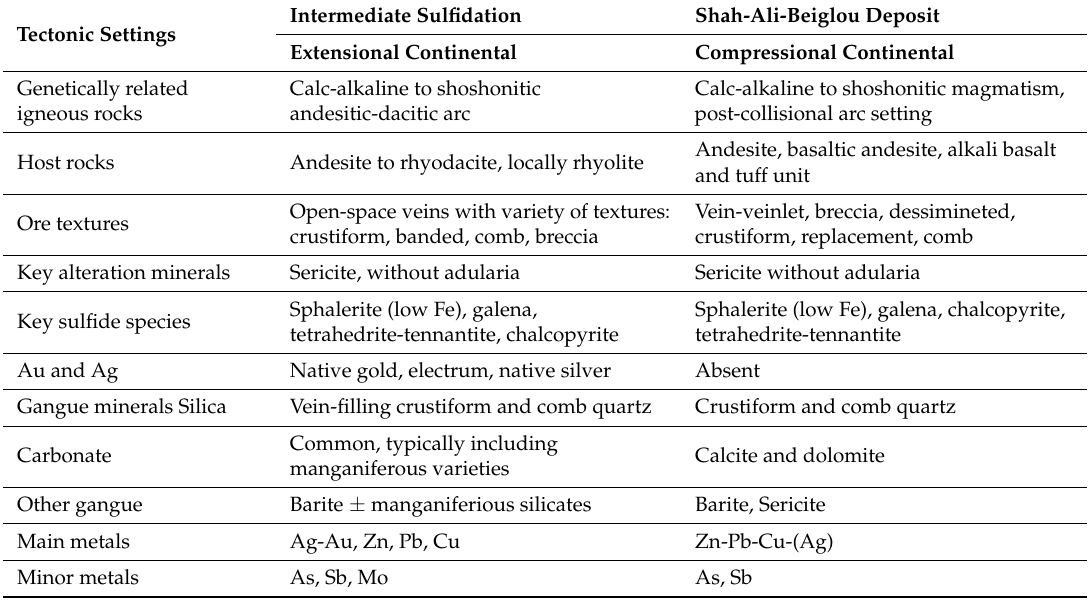
Table 8. Comparative characteristics of the main features of the Shah-Ali-Beiglou deposit and intermediate sulfidation type deposits (after Sillitoe and Hedenquist, [102]) and Shah-Ali-Beiglou